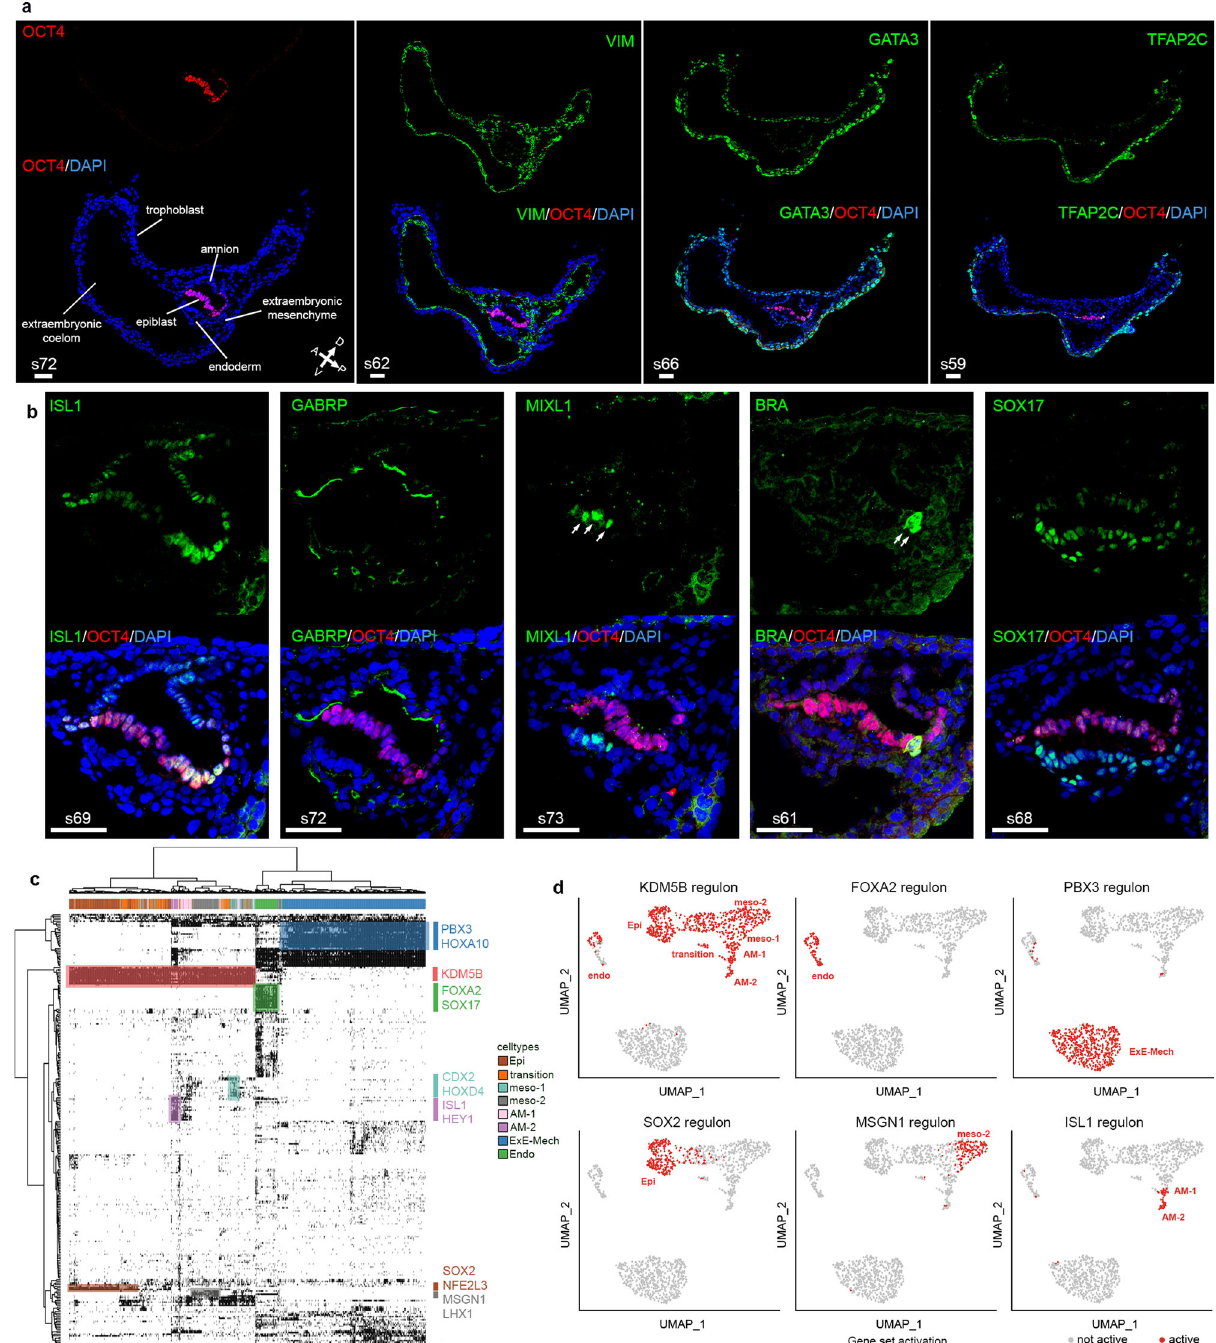
Fig. 2 Immuno fl uorescent staining and gene regulatory networks in wild-type in vitro cultured NHP embryos. See also Supplementary Fig. 6 and Supplementary Data 4. a , b immuno fl uorescent staining of major cell types at Day 14 identi fi ed in the scRNA sequencing. n = 2 wild-type embryos a OCT4, VIM, GATA3, TFAP2C; b ISL1, GABRP, MIXL1, BRA, and SOX17. Scale bar = 50 µ m. White numbers indicate section numbers and arrows indicate the signal of interest. c Binary activity matrix of regulons identi fi ed at Day 14 by gene regulatory network inference active in at least 1% of the cells clustered unsupervised. Selected master regulators are depicted in the color corresponding to the cell type they show activity in. d Binarized gene set activity of the selected regulons at Day 14 in the different cell types depicted on the UMAP plot from Fig. 1d. Epi epiblast, Endo endoderm, ExE-Mech